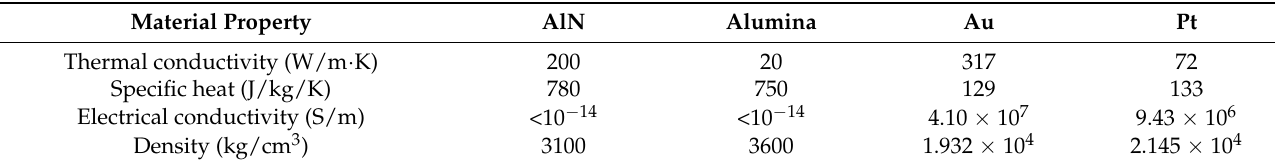
Figure 3. Simulated 3D perspective models of the ( a ) first, ( b ) second, and ( c ) third designs. Heat is transferred by heat conduction, heat convection, and heat radiation. The temperature of the chip increases during operation, and the material parameters of the components change with temperature from the ambient temperature of 20 °C. This behavior makes it impossible to quantify the heat transfer between the components and the heat convection between the chip and environment. The heat transfer from the chip is hence quantified by reducing the dynamic heat transfer process to a steady-state heat transfer. The parameter values used for the material are listed in Table 1. Table 1. Main material parameters used in the simulation .